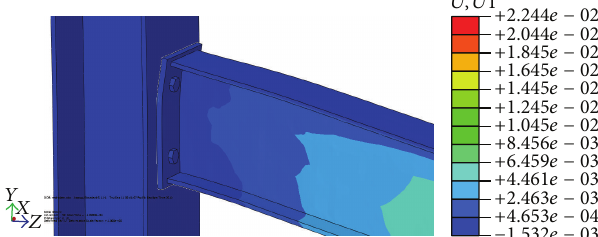
Figure 16: Out-of-plane buckling of the beam web for connection to the end plate.